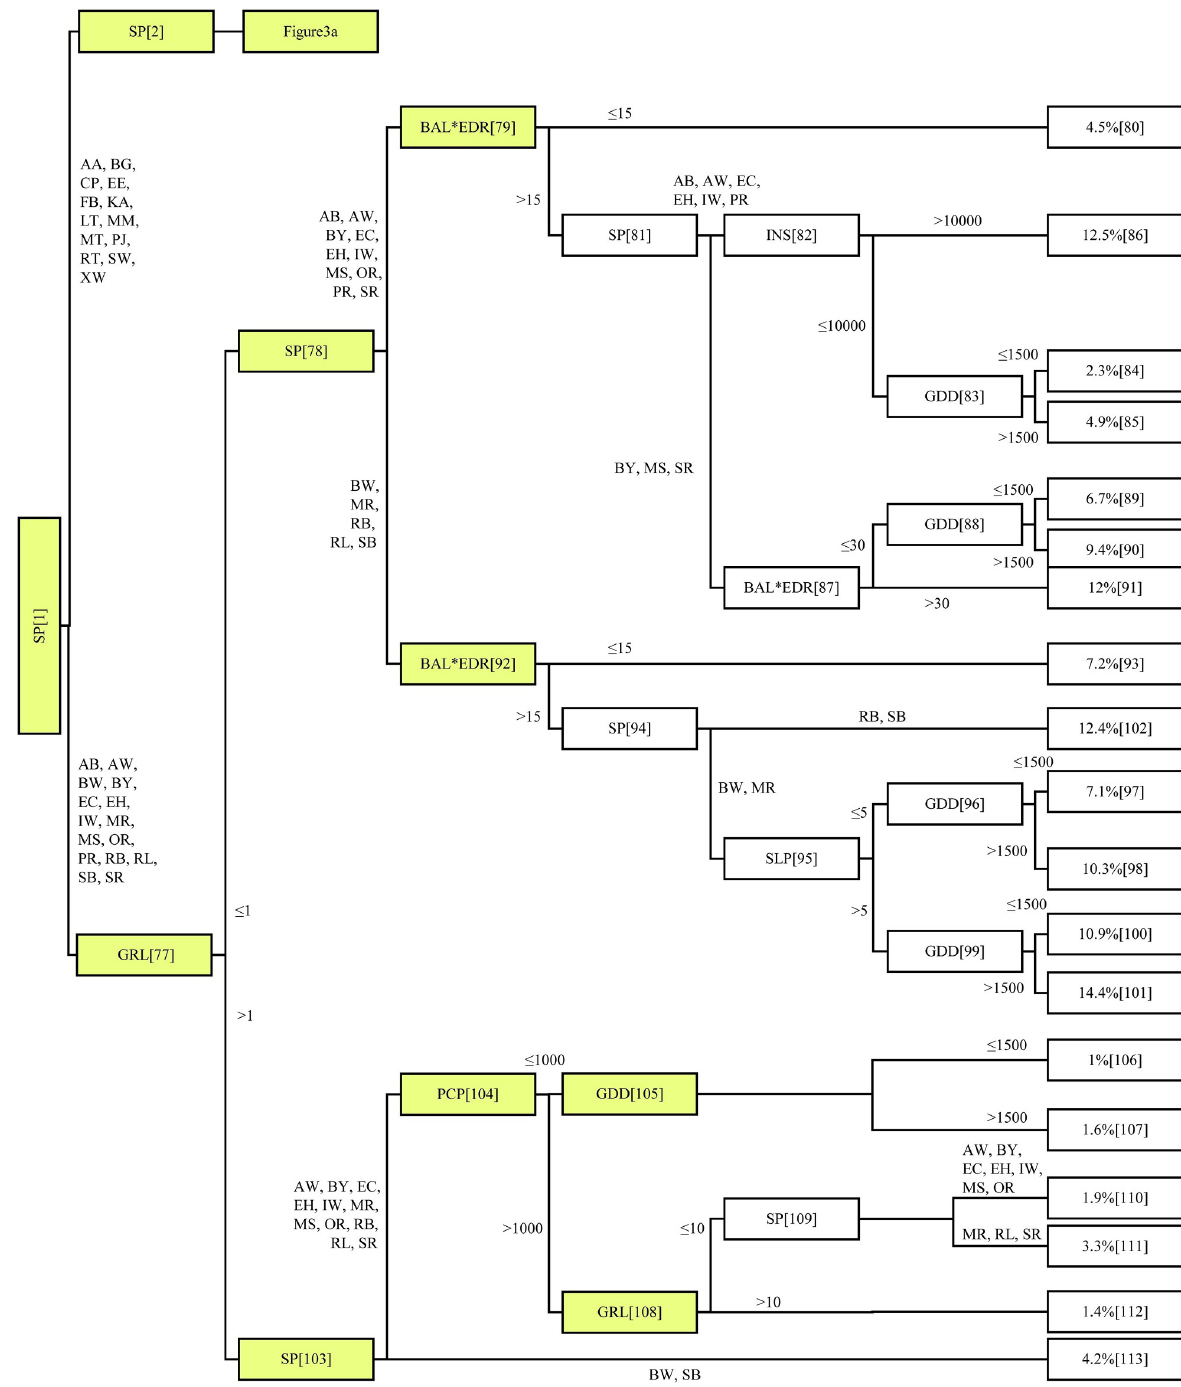
Fig 4. Nodes 77–108 of the conditional inference tree (CTREE) of rate of mortality for 28 boreal and temperate species (see Table 2, for code definition). Tree-level variables include species (SP), average annual basal area growth increment ( Δ BA ), basal area of the largest tree and relative density interaction ( BAL×EDR ). Stand-level variables include potential solar radiation (INS), and slope (SLP). Climatic variables include cumulative annual growing degree days (GDD) and cumulative annual precipitation (PCP). The terminal nodes, 19 in total, show the proportion of dead trees. Nodes shaded yellow were consistent in all folds in model